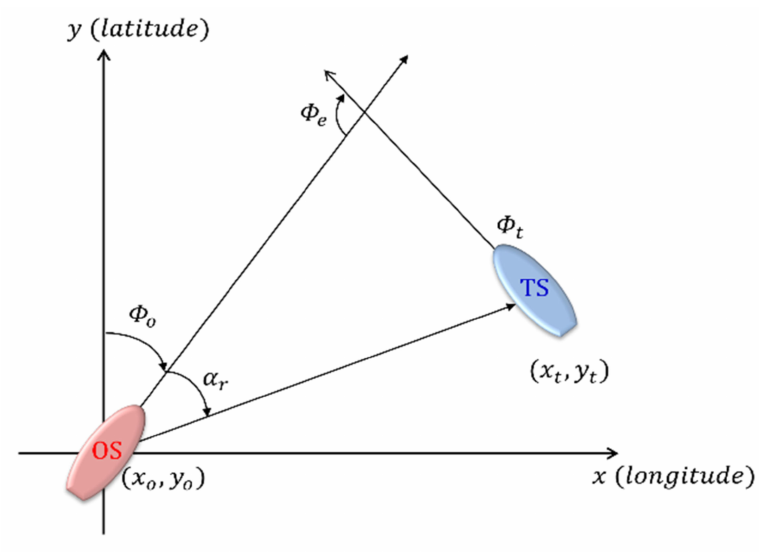
Figure 3. Relative bearing and encounter